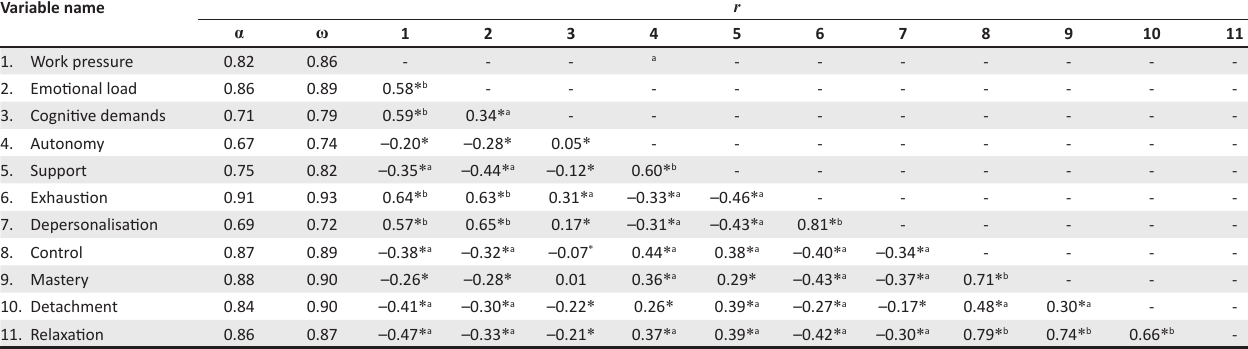
TABLE 1: Correlation matrix of the latent variables ( N =